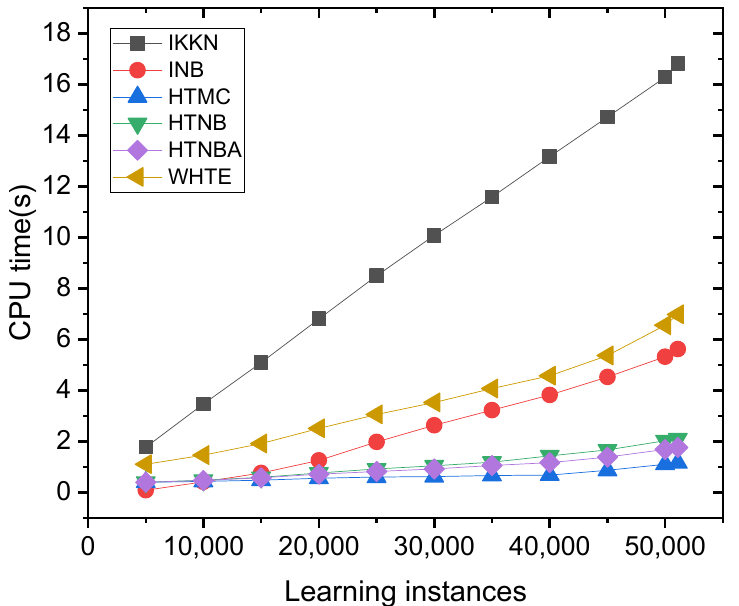
Figure 9. The comparison of the CPU time for all the methods applied on the dataset of the Modbus sensor.